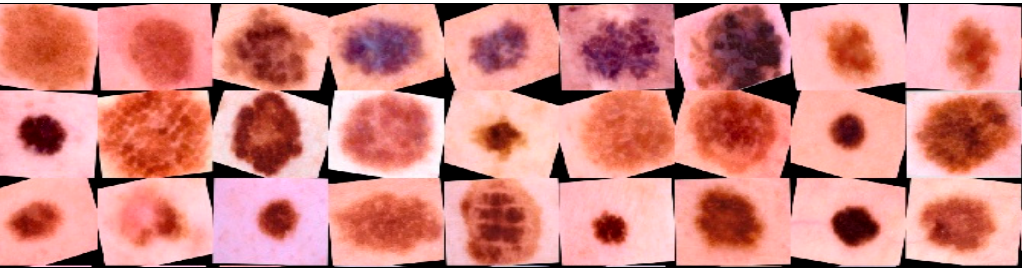
Figure 12. Examples of dermatoscopic training images that have been previously cleaned and enlarged using affinity transformations. Scale bar or magnification.